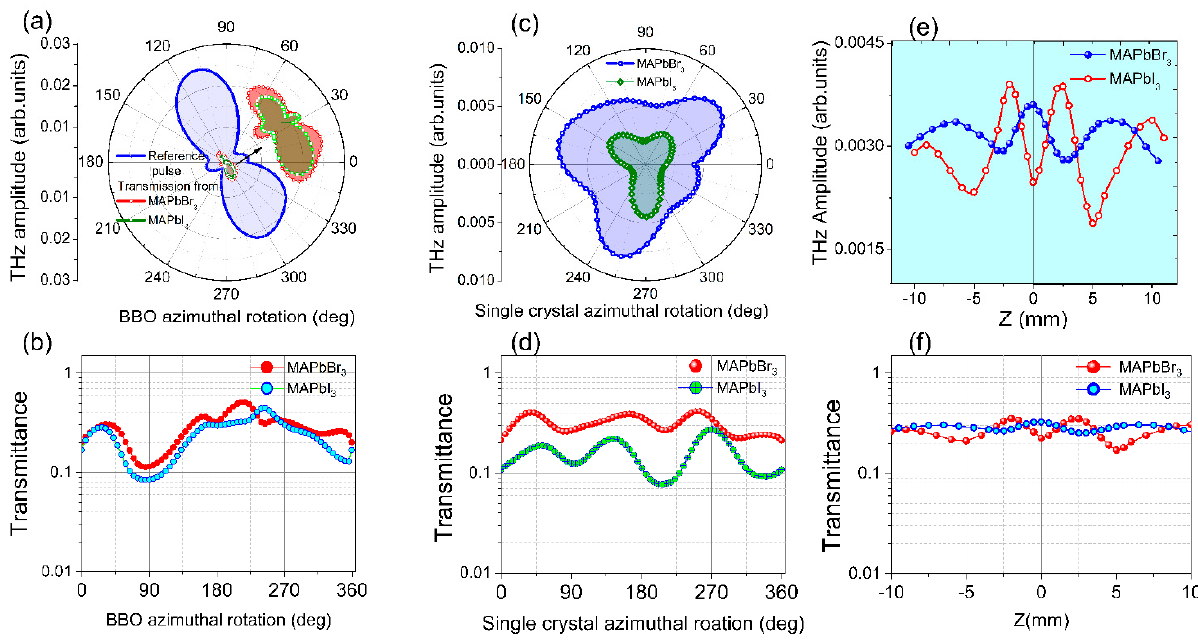
Figure 7. The peak amplitudes of ( a ) reference THz pulse and transmission from PSCs’ ( b ) measured transmittance. At optimized THz reference pulse, transmitted THz peak amplitudes, transmittance from PSCs w.r. to ( c , d ) azimuthal rotation ( e , f ) moved along the z -axis near the focal plane of MAPbBr 3 and MAPbI 3 single crystals,